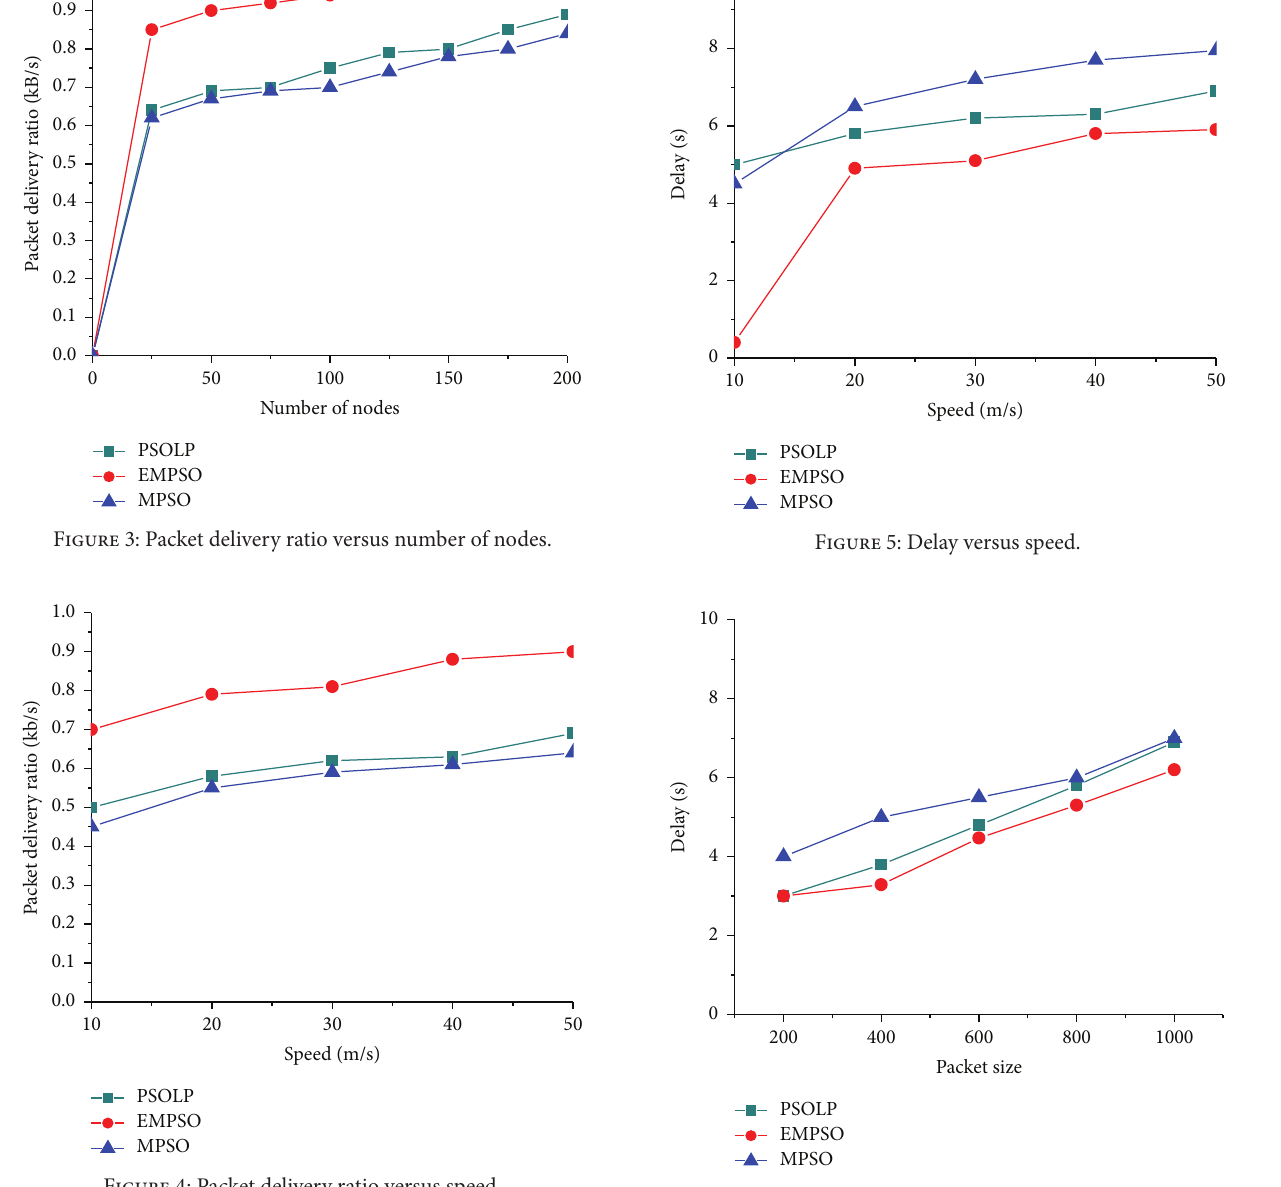
Figure 4: Packet delivery ratio versus speed.